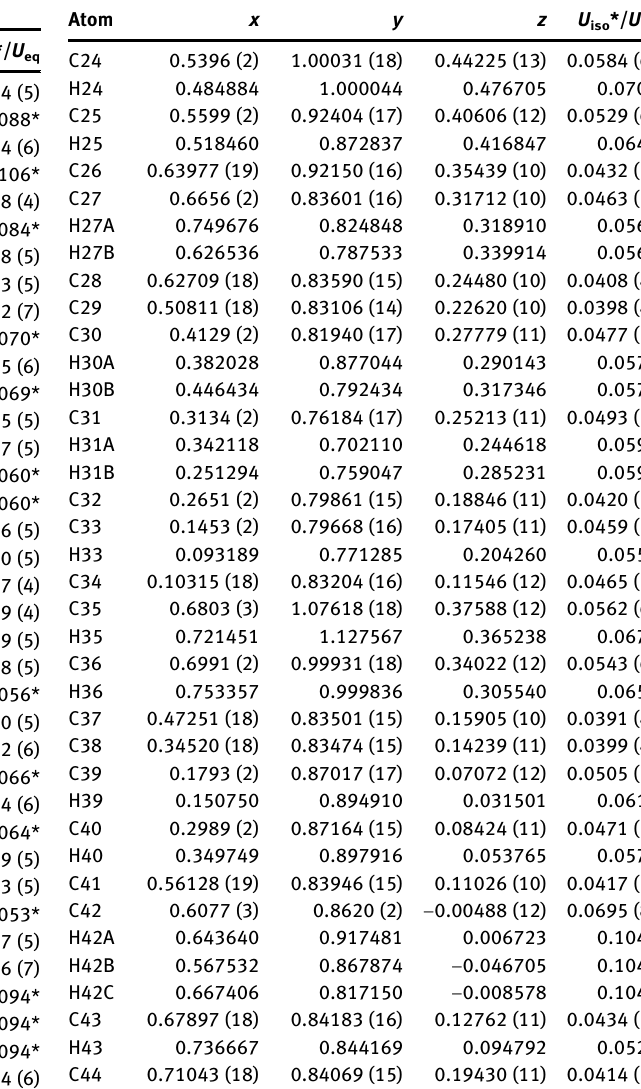
Table  : Fractional atomic coordinates and isotropic or equivalent isotropic displacement parameters (Å 